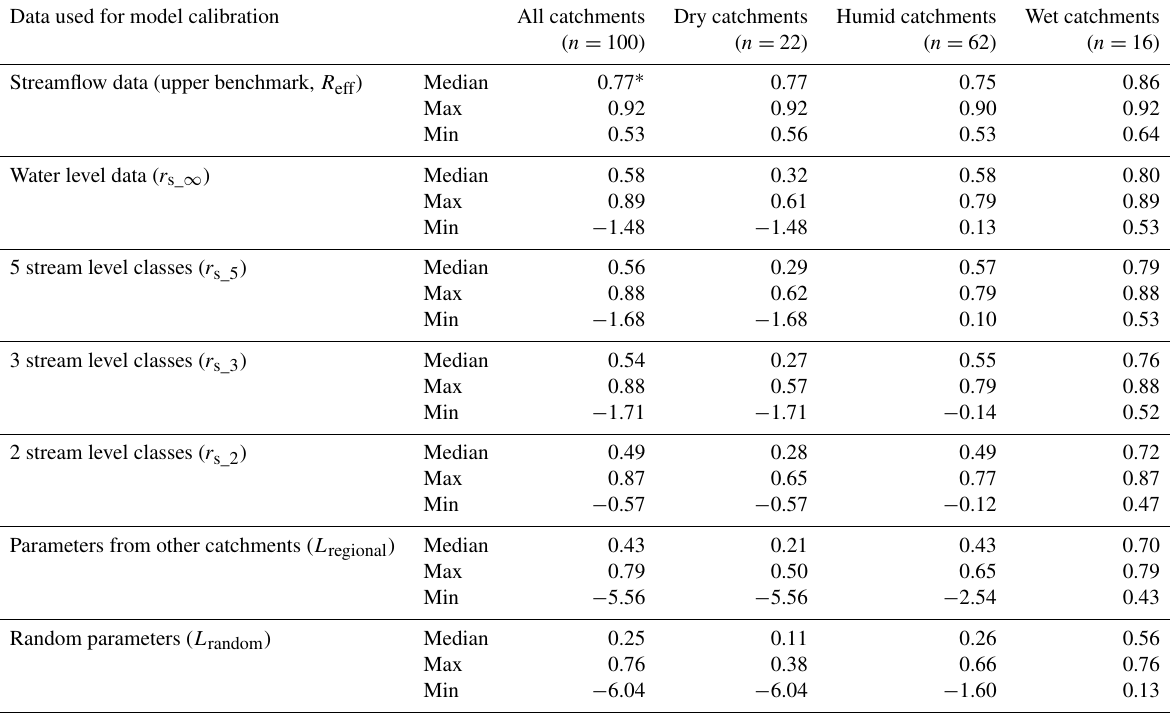
Table 1. Median, maximum and minimum model efficiencies for the 100 catchments for model calibrations using different types of data and the two lower benchmarks. Note that the difference in the median model efficiency for the model calibrations with all streamflow data ( R eff ) and the median model efficiency for the model calibrations with data for n water level classes ( r s_ n ) is not the same as the median of the differences in efficiency between the model calibrated with all streamflow data and the model calibrated with the stream level class data ( (cid:49)R eff ) that is reported in the text and shown in the